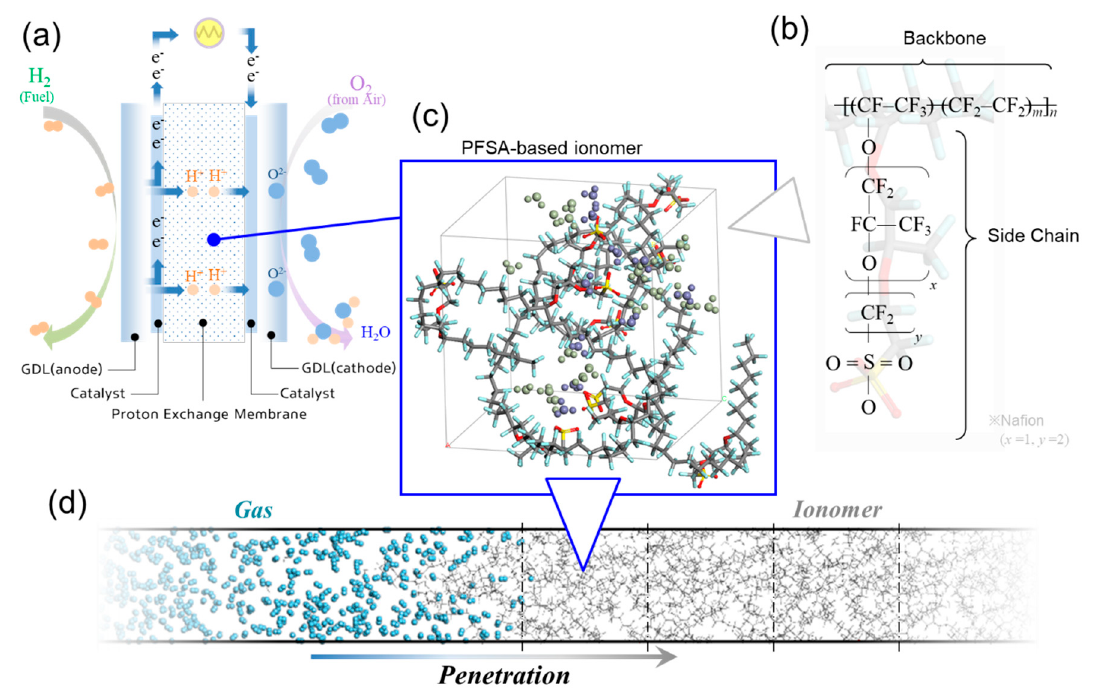
Figure 1. ( a ) Schematic of the operation of a fuel cell; ( b ) snapshot of the unit cell for the molecular dynamic (MD) simulation of the morphological effect of the side chain on gas penetration, containing H 3 O + and H 2 O with the hydration number of 3; ( c ) index x (backbone) and y (side chain) of the chemical structure of perfluorosulfonic acid determine the length of side chain; and ( d ) schematic of the MD simulation for hydrogen molecules’ penetration into the ionomer region.